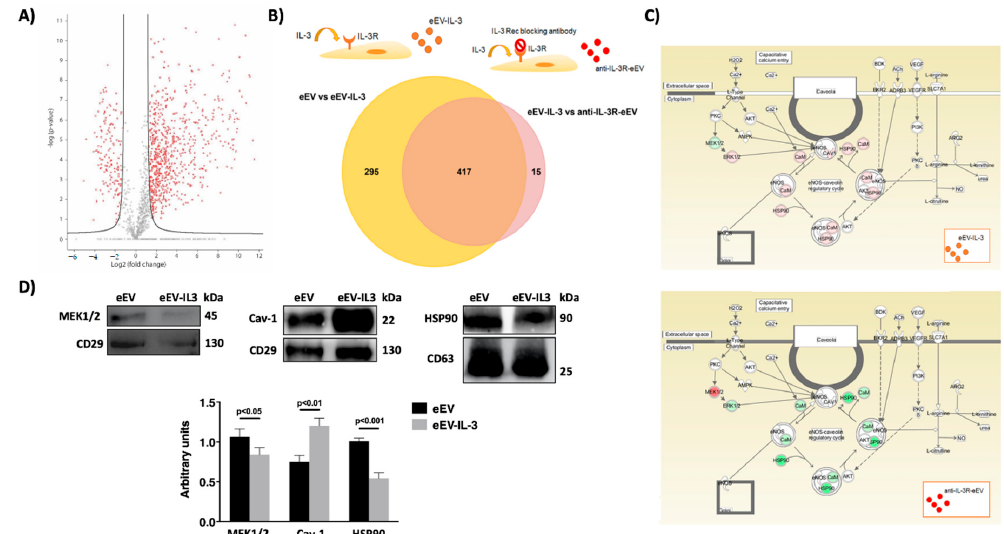
Figure 4. Protein profiling of eEV-IL-3 compared to eEV. ( A ) Volcano plot of IL-3 induced protein changes by label-free quantitation. Protein expression ratio of eEV-IL3/eEV (log2 scale) in label-free quantitation plotted against the -log of two-sample t -test. The lines represent threshold values ( p -value 0.05, Fold Change >2). ( B ) Venn diagram. Venn diagram shows proteins in eEV-IL-3 compared to eEV (yellow) and anti-IL-3R-eEV (dark pink). Proteins included in the light pink area correspond to proteins only carried by anti-IL-3R-eEV. ( C ) nitric oxide signaling in the cardiovascular system. In the scheme, proteins modulated in eEV-IL-3 vs. eEV (upper panel) and homecoming in anti-IL-3R-eEV (lower panel) are highlighted. Red corresponds to increased expression; green corresponds to reduced expression. ( D ) Western blot analysis of eEV and eEV-IL-3. Representative image and relative quantification of MEK1/2 and the negative eNOS regulator, caveolin-1, HSP90 normalized to CD63 and to CD29 respectively (an aliquot of the three pooled samples were used) (MEK1/2: p < 0.05 eEV vs. eEV-IL-3; Caveolin-1: p < 0.01 eEV vs. eEV-IL-3; HSP90: p < 0.001 eEV vs.